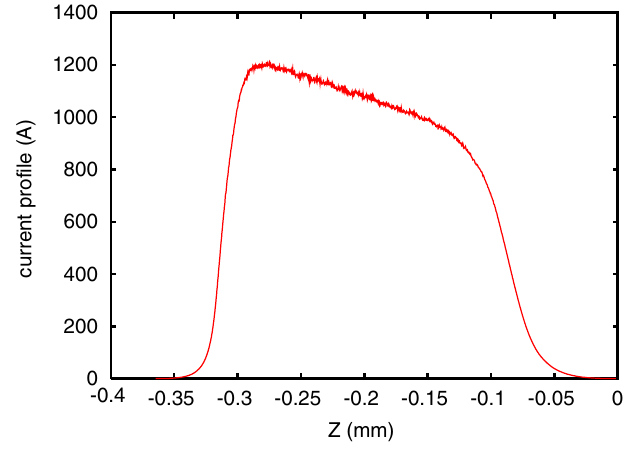
FIG. 12. (Color) Current profile at the end of the linac with initial 5 keV rms uncorrelated energy